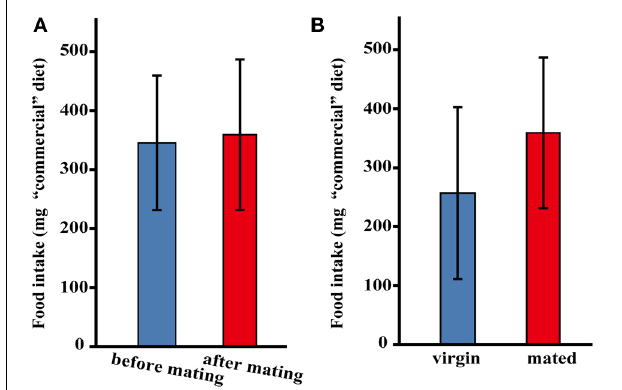
FIGURE 1 | The amount of “commercial” diet intake after mating in G. bimaculatus females. The amount of food intake by G. bimaculatus adult females after mating was measured by consumption of “commercial” diet tablets. (A) The amount of food intake by individual females before mating was also measured as a control. N = 8, Mean ± SD . Data was statistically analyzed using a paired t- test. The amount of food intake by females before and after mating was compared. (B) The amount of food intake by the mated females was measured by comparing to the amounts of food intake by the virgin females. Mated females; N = 8, virgin females; N = 10, Mean ± SD . Data was statistically analyzed using Dunnett’s test.